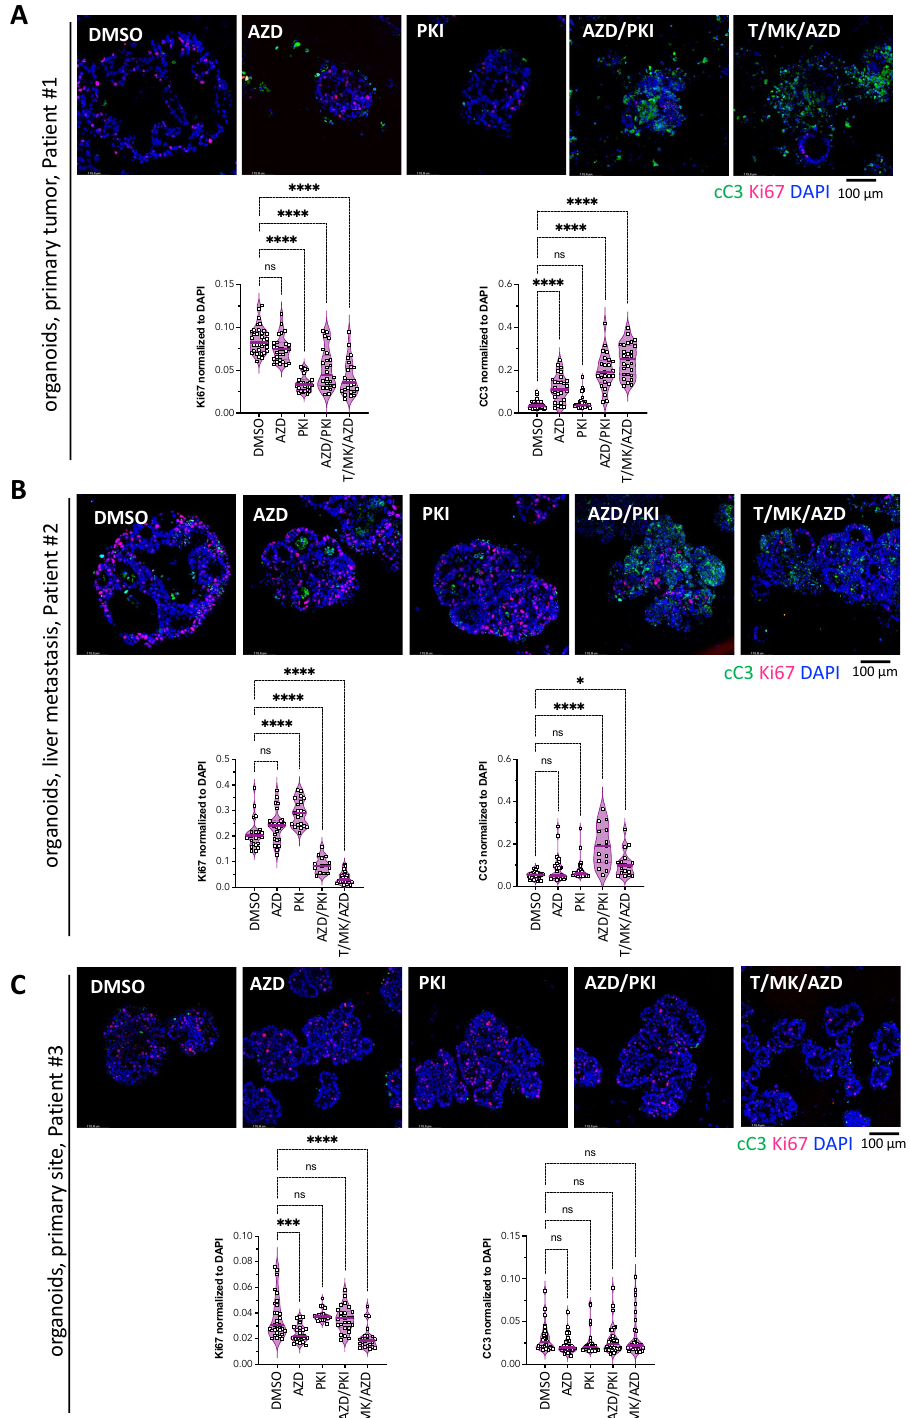
Figure 6. Analysis of proliferation and apoptosis in colon cancer organoids under treatment. Repre- sentative confocal immunofluorescent images of the human organoids from Figure 5 after 48 h of treatment stained for Ki67 and cC3 to assess proliferation and apoptosis. Quantification of mean fluorescence intensities (MFI, bars) of cC3 and Ki67 normalized to DAPI in five different organoids at three different optical sections each. Dots in violin plots indicate fluorescence intensity of individual images. ( A ) Organoids from the primary colon cancer from patient #1, ( B ) liver metastatic colon cancer organoids form patient #2. ( C ) Primary colon cancer organoids from patient #3. Asterisks indicate significant changes; ns,